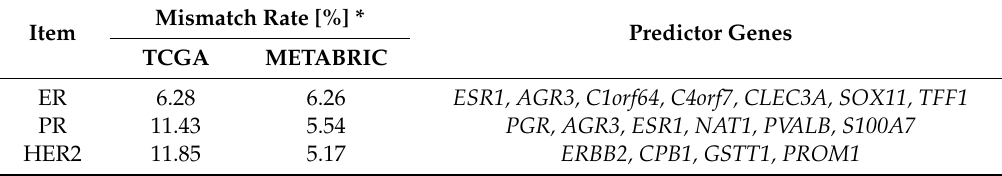
Predictor Genes